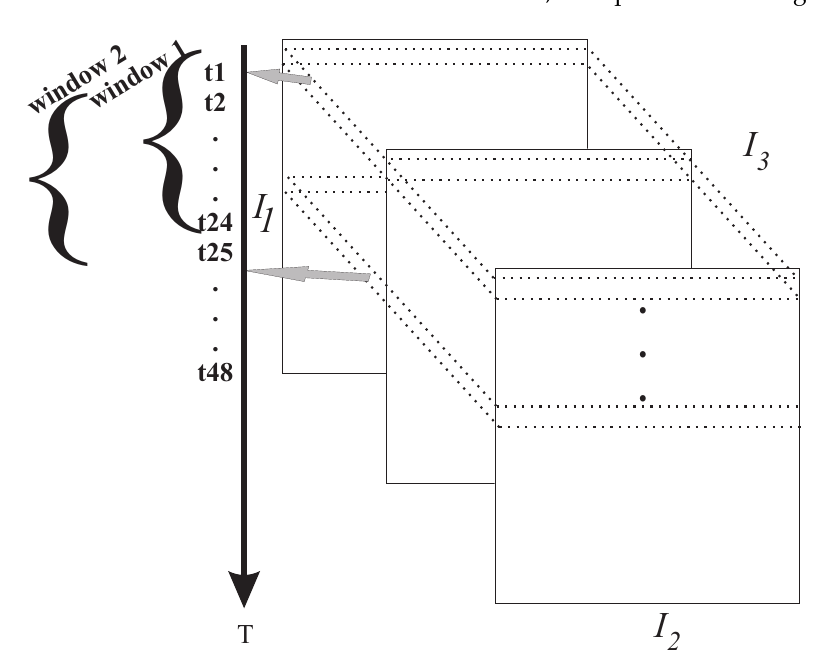
Figure 1. Monitoring online: Sliding